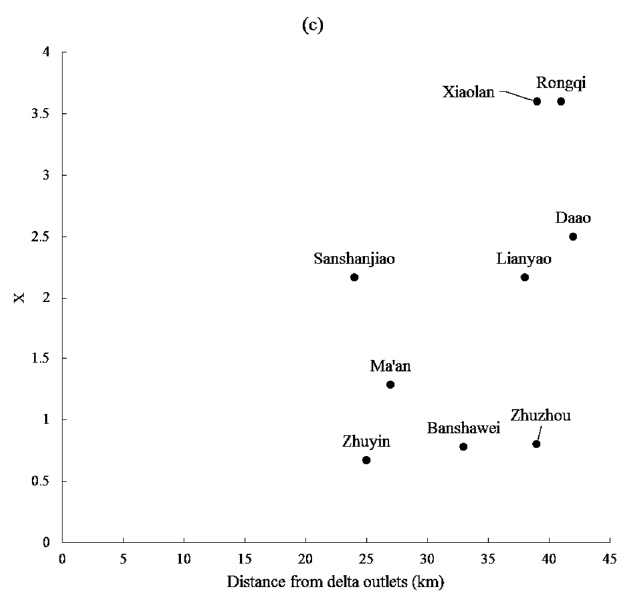
Figure 8. X s of stations in Pearl River Delta: ( a ) stations with X ≥ 5; ( b ) stations with X ≤ 0.5; ( c ) stations with 0.5 < X < 5 .